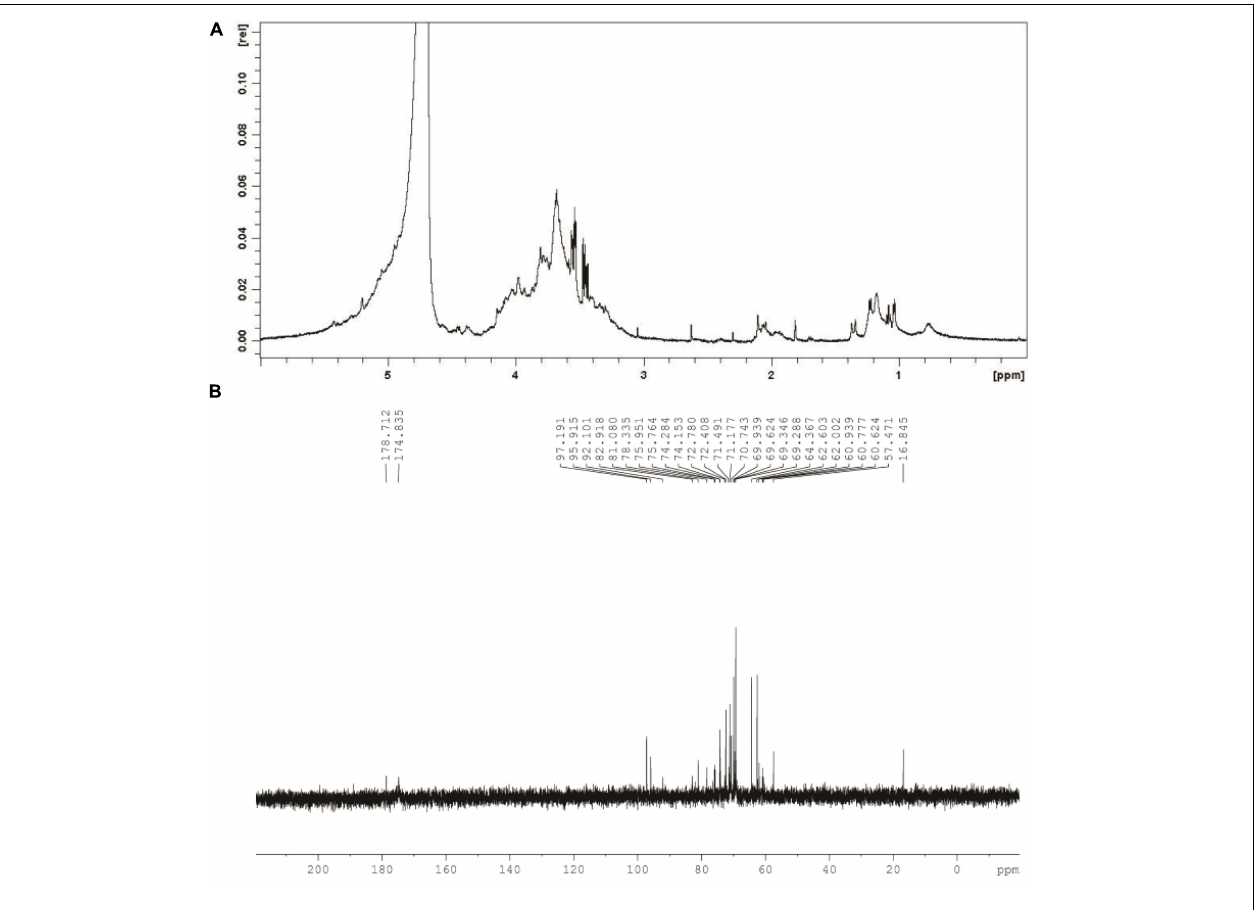
FIGURE 3 | 1 H nuclear magnetic resonance (NMR) spectrum (A) and 13 C NMR spectrum (B) of